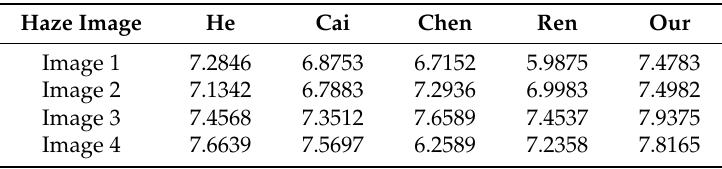
Table 2. The information entropy from images shown in Figure 13.